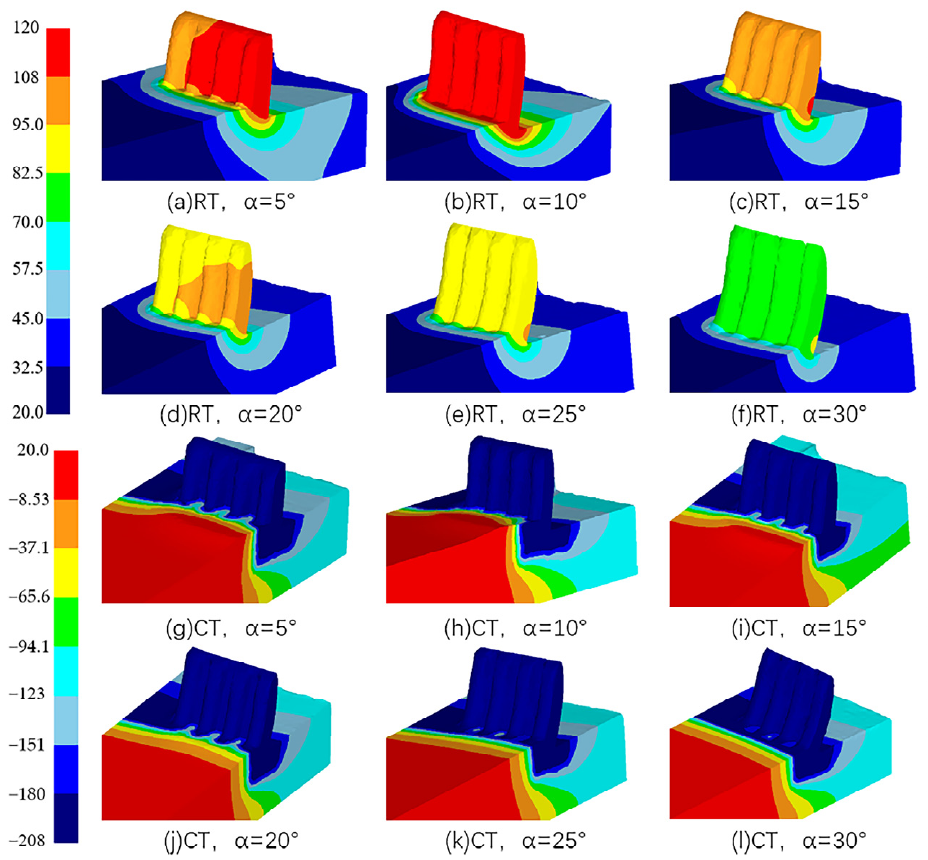
Figure 12. Temperature distribution of the fins under different conditions. Figure 13 depicts the temperature variation curves of RT-EM and CT-EM along the DEFG trajectory under different values of α . The temperature at the bottom of the micro- groove and the second deformation zone is relatively high. The maximum temperatures of RT-EM and CT-EM under different values of α are 115 ◦ C, 112 ◦ C, 102 ◦ C, 97 ◦ C, 91 ◦ C, 87 ◦ C, − 166 ◦ C, − 165 ◦ C, − 168 ◦ C, − 180 ◦ C, − 176 ◦ C and − 182 ◦ C, and the maximum temperature gradually decreases. The temperature of CT-EM fins in the deformation zone is kept below − 160 ◦ C and the temperature curves of the different values of α change slightly. The higher the temperature of the metal material during processing, the better the fluidity of materials. Compared with the other three groups of variables, the maximum temperature corresponding to different values of α is lower. At an α of 30 ◦ , the temperature of RT-EM and CT-EM is the lowest, which is harmful to improving the formability of